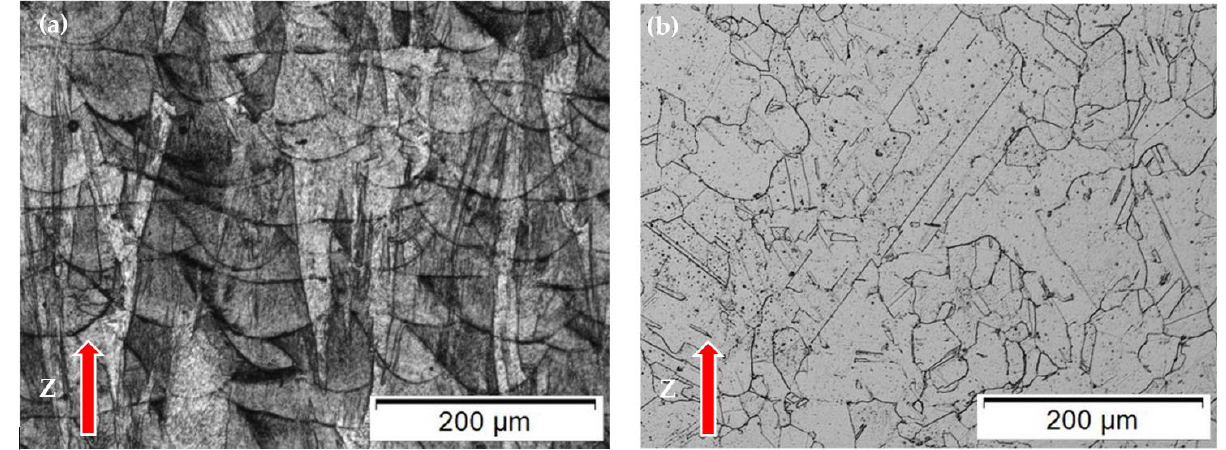
Figure 3. L-PBF optical microscope images: ( a ) as-built, ( b ) heat-treated.